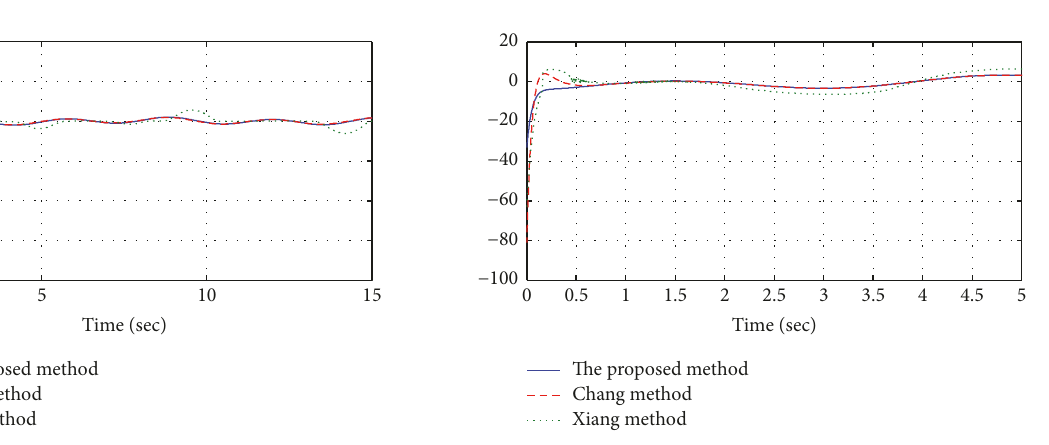
Figure 4: System output 𝑦 1 of the three methods.